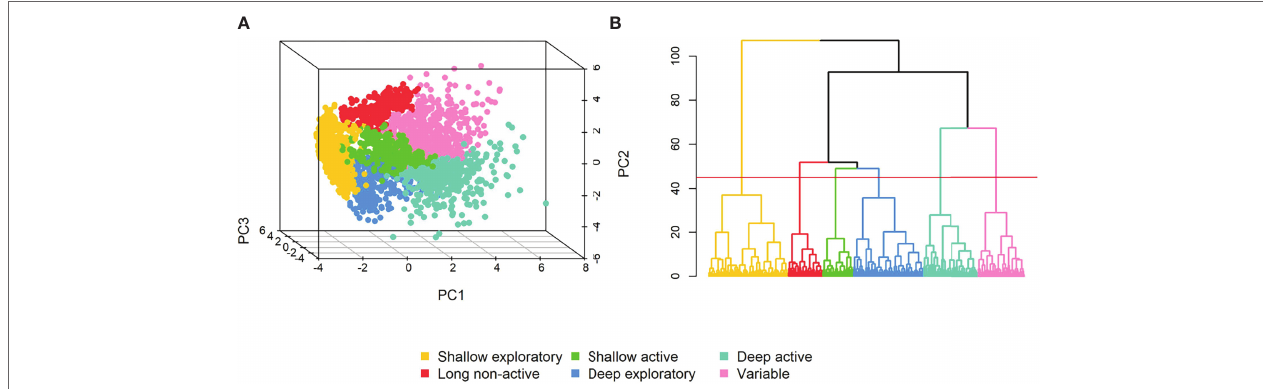
FIGURE 2 | 3D scatterplot of the first three components of the PCA (A) and dendrogram of the hierarchical clustering analysis of 10 dive variables (B) , where the y-axis represents the dissimilarity between clusters (height) and the red line the level at which the dendrogram was